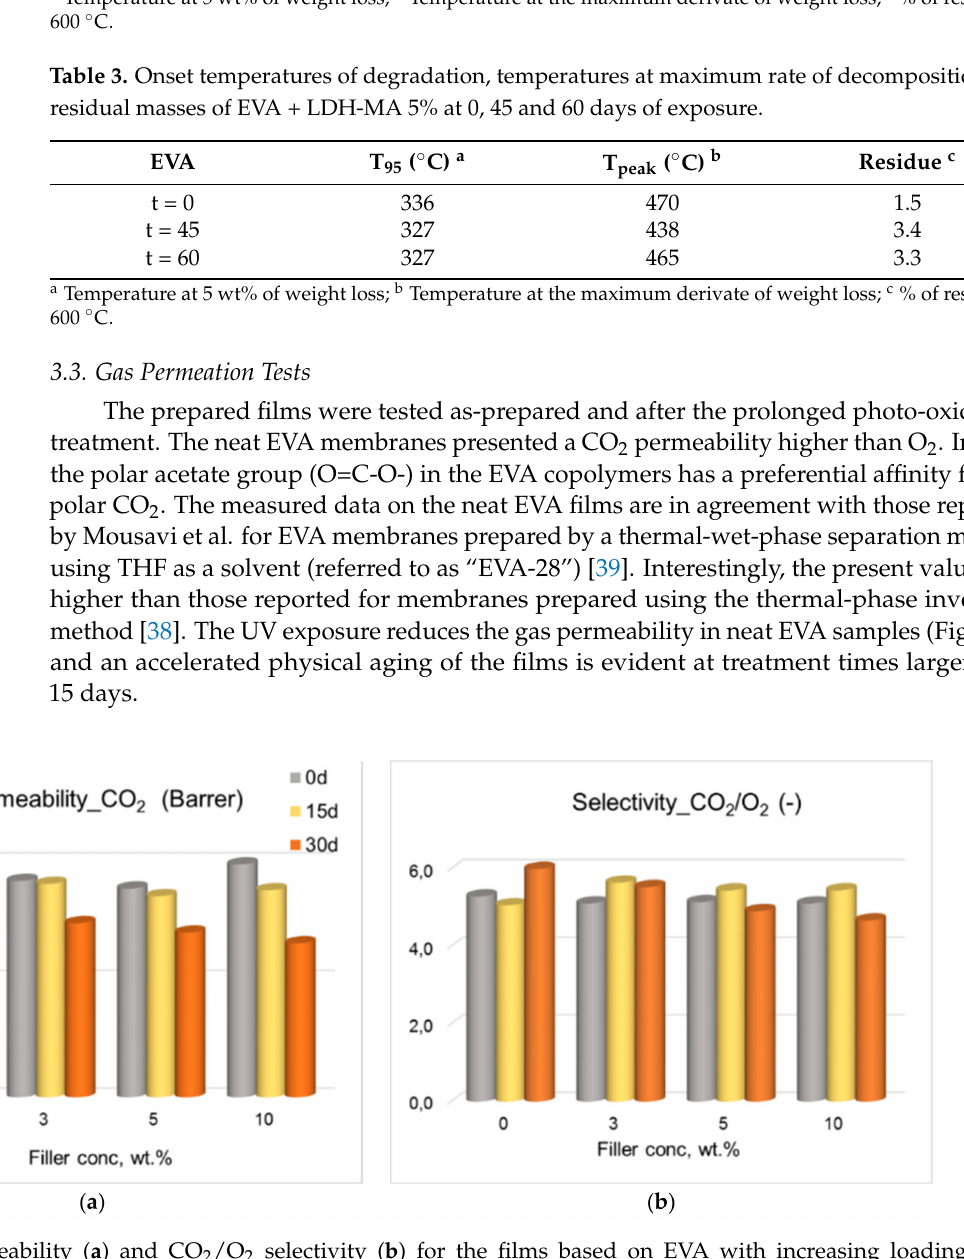
Figure 7. CO 2 permeability ( a ) and CO 2 /O 2 selectivity ( b ) for the films based on EVA with increasing loadings of LDH-MA. Film conditions: “as-prepared” (0 days) and photo-exposed (15 and 30 days). 1 Barrer = 10–10 cm 3 (STP) cm cm − 2 cmHg − 1 s − 1